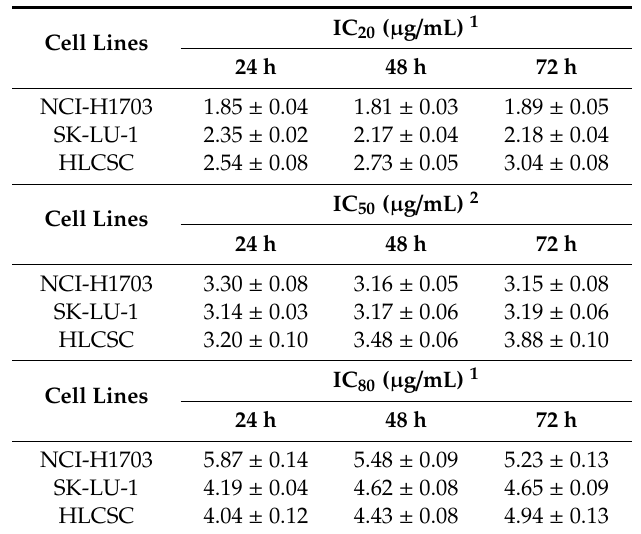
Table 1. IC 20 , IC 50 , and IC 80 values of chelerythrine